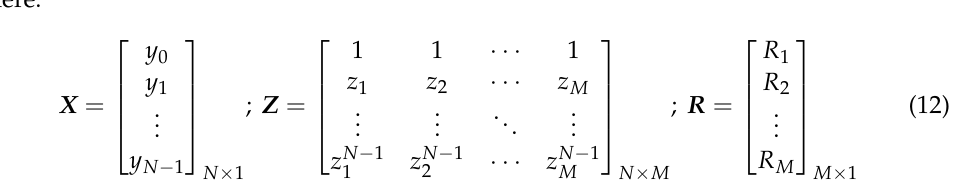
Figure 2. Residues of components of Gaussian approximations.